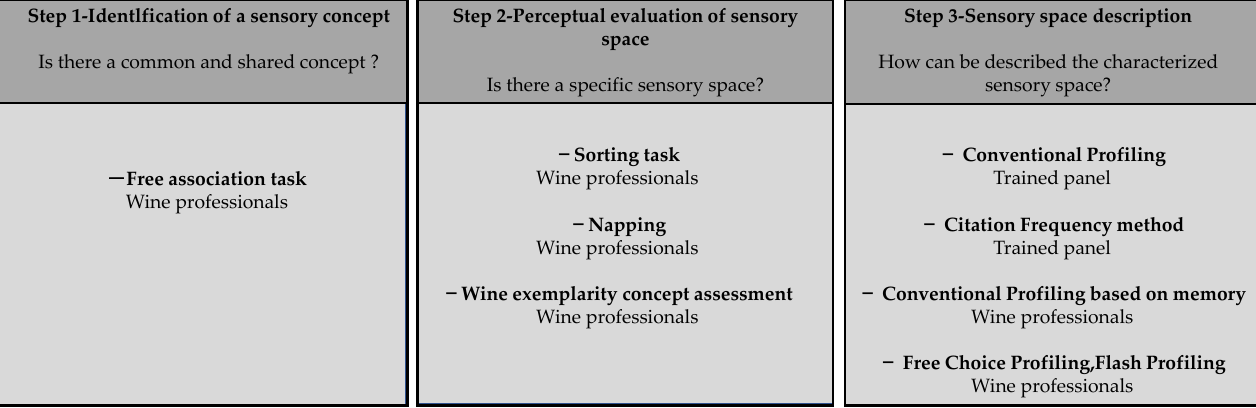
Figure 1. Three-step approach for sensory space characterization: from concept to evaluation and